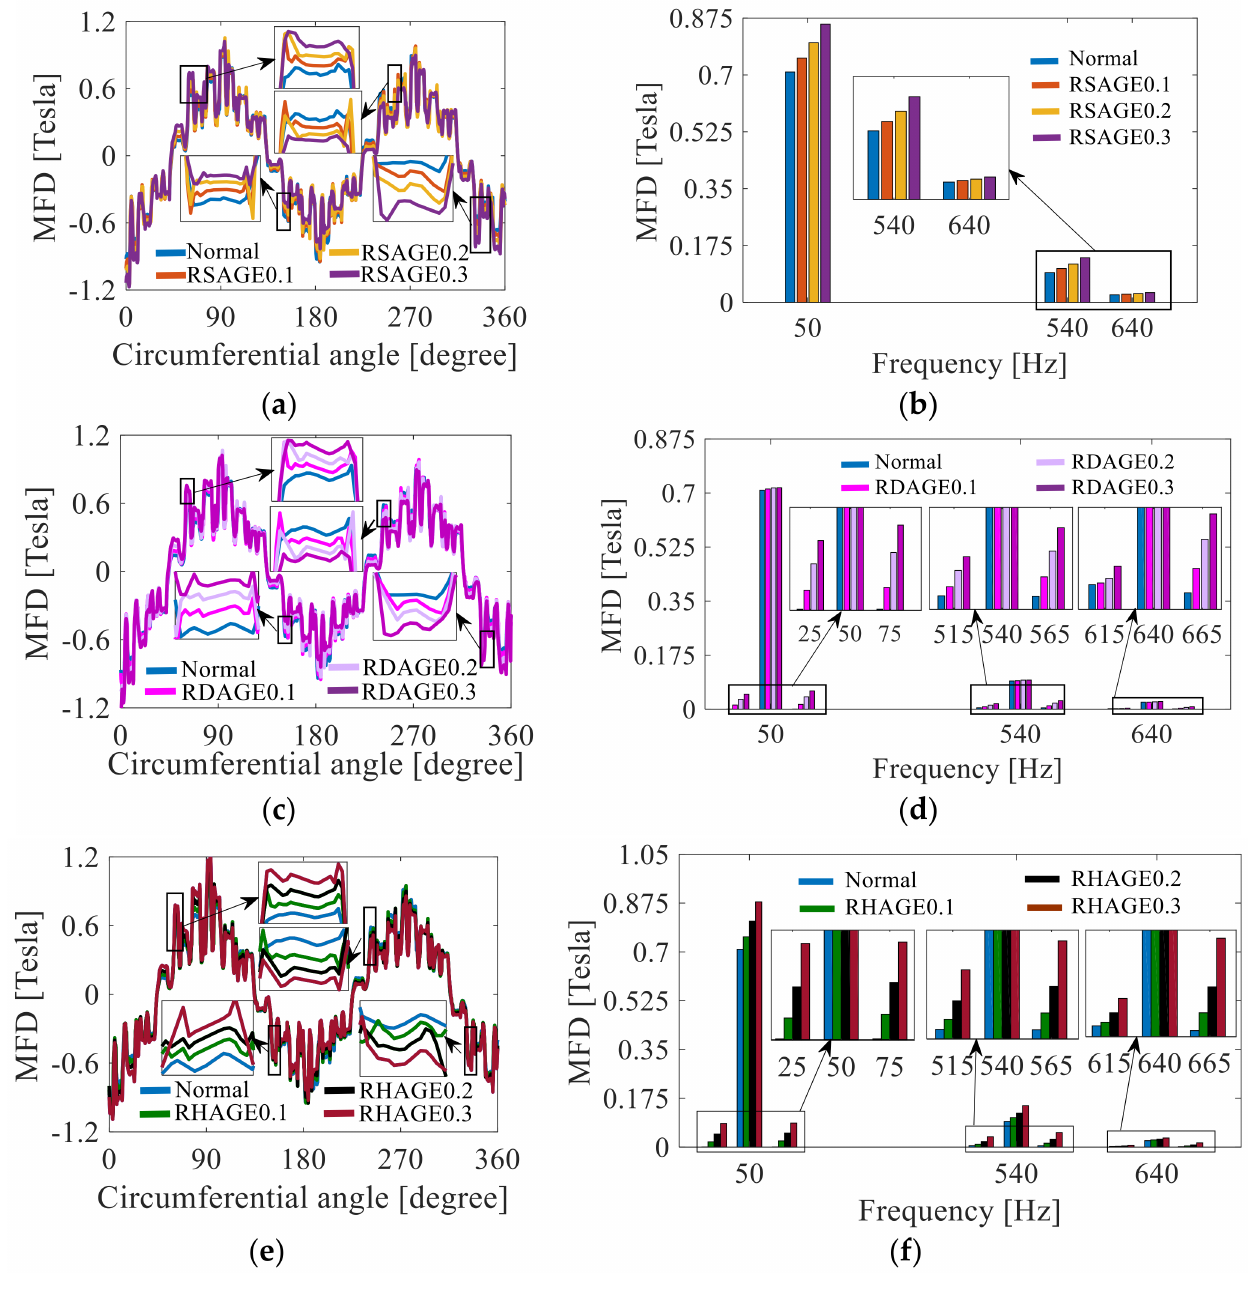
Figure 7. The MFD in before and after RAGE conditions: ( a ) the MFD time domain in RSAGE; ( b ) the frequency domain in RSAGE; ( c ) the MFD time domain in RDAGE; ( d ) the frequency domain in RDAGE; ( e ) the MFD time domain in RHAGE; ( f ) the frequency domain in RHAGE. From Figure 8b,d,f, it can be derived that the CCPB frequency components f 1 (50) and f u (540/640) were induced when RSAGE occurred. Similarly, RDAGE yielded f 1 ± f r (25/75) and f u ± f r (515/565/615/665, k 2 = ± 1) for the CCPB frequency components. The frequency components of the CCPB during RHAGR were the superposition of RSAGR and RDAGR. Generally, with the increase in RAGE, the amplitude of each component also increased. The frequency component calculated by using FEA was consistent with the theoretical